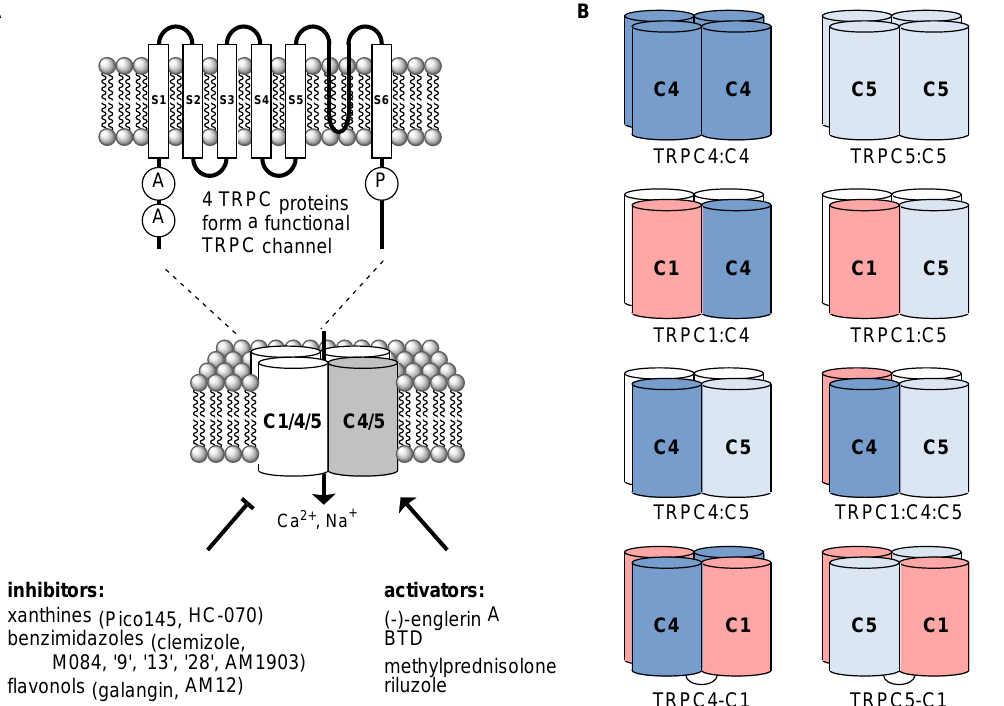
Figure 1. ( A ) Formation of tetrameric TRPC1/4/5 cation channels by TRPC1/4/5 proteins and recently discovered small-molecule modulators discussed in this review. Domains “A” are the ankyrin repeat domains present in all TRPC proteins, and “P” is the PDZ binding domain present in TRPC4 and TRPC5. ( B ) Composition of different TRPC1/4/5 channels discussed in this review. Native channels are believed to exist predominantly as heteromers, but their exact compositions and stoichiometries are often unknown (as depicted by white subunits, which may be TRPC1/4/5 proteins or other TRP(C) proteins). Linked subunits depict recombinant TRPC4–C1 and TRPC5–C1 concatemeric proteins that can be used to control channel